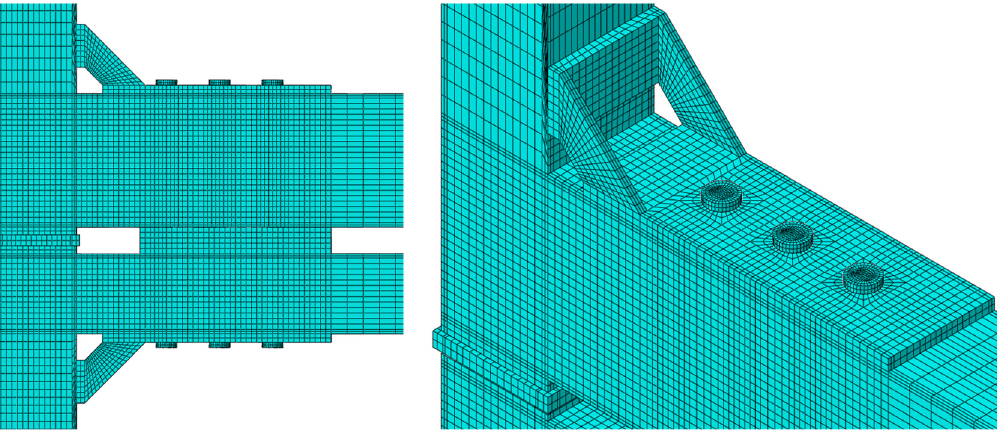
Figure 2. Different mesh sizes employed.